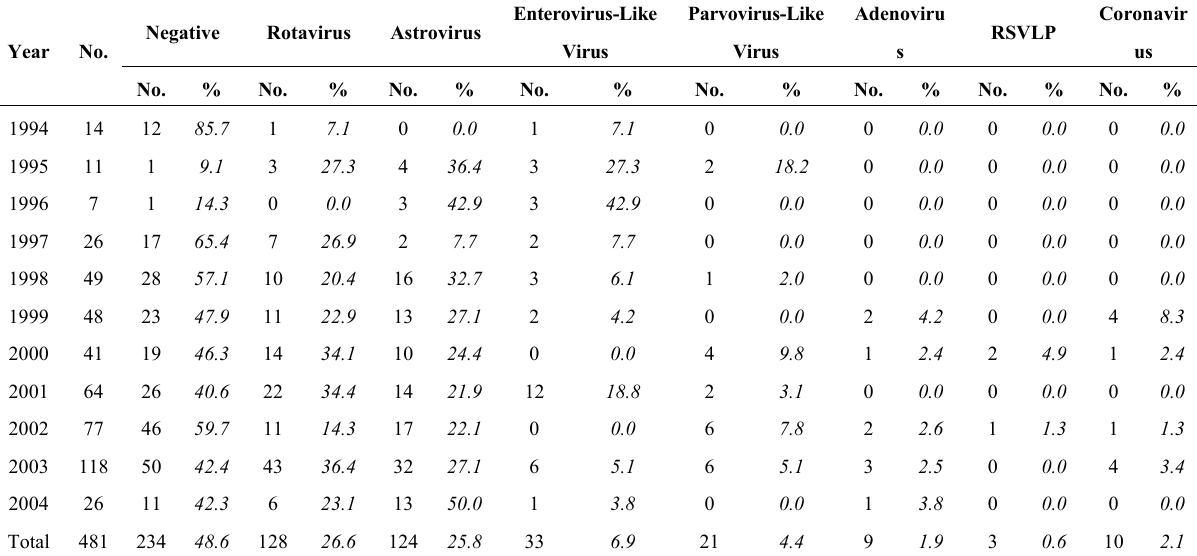
Table 3. Distribution of viral positivity by year and type of virus in fecal samples of 1–5 week old turkey poults showing enteritis. The numbers in italics indicate the percentages calculated based on the total examinations performed each year. The percentage of the positives exams is based on the total examinations although some examinations resulted in more than one positive identification due to the occurrence of multiple infections with two or more viruses in